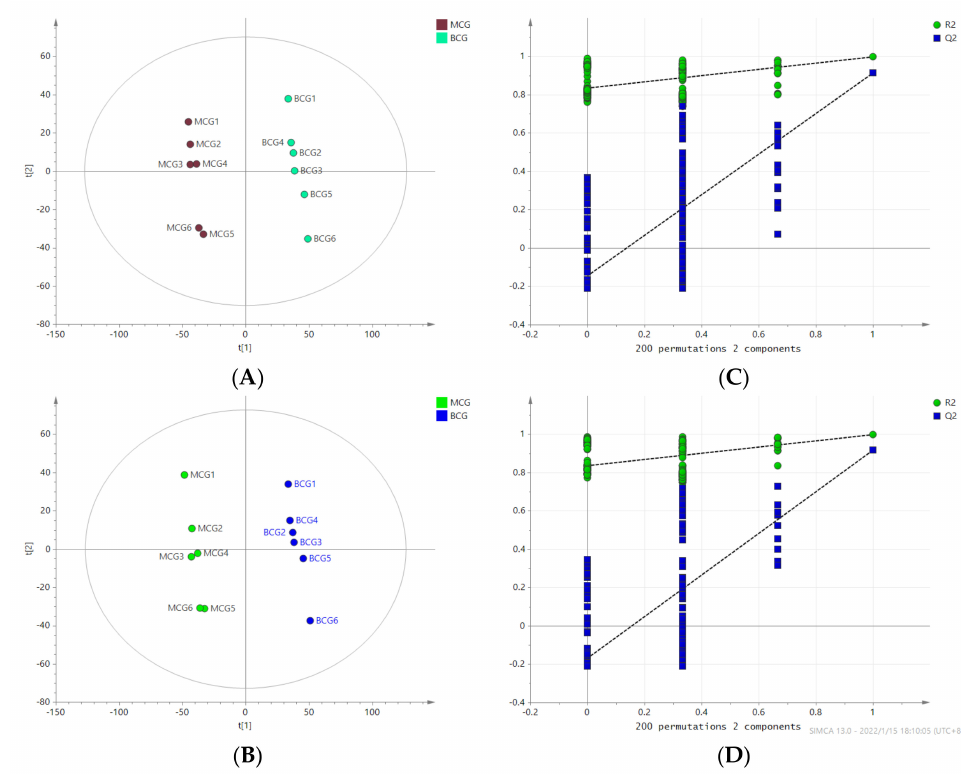
Figure 4. OPLS-DA score and OPLS-DA model response permutation verification map between blank control and model control group (( A , C ): Negative ion mode, ( B , D ): Positive ion mode).